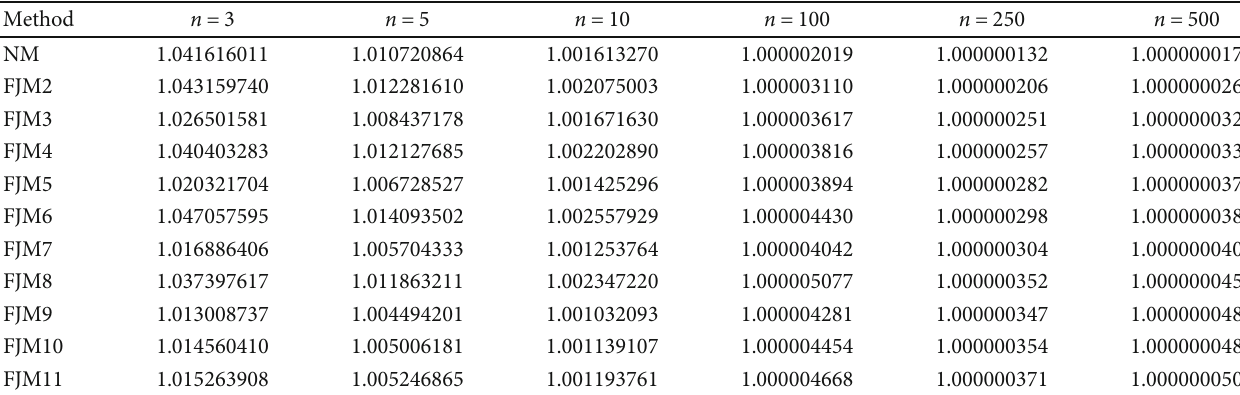
n = 3, 5, 10,100,250,500 .